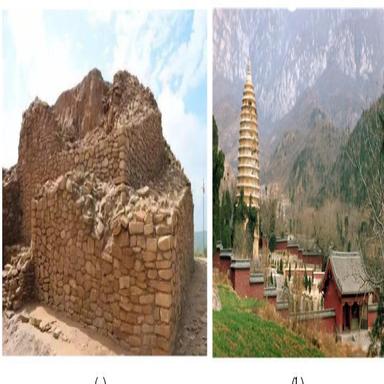
(a) Shimao ancient city, Shaanxi, China (4300BCE), and (b) Songyue Pagoda, Henan, China (523 CE).